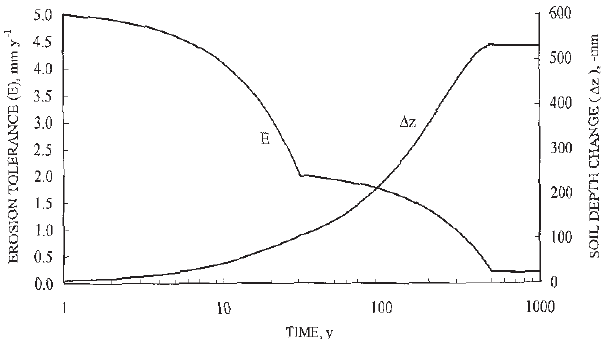
Figure 1. Shows an example of erosion tolerance determination considering the following values: E 0 = 5.0 mm y -1 , P = 0.2 mm y -1 , t 1 = 30 y, E 1 = 2.0 mm y -1 , t 2 = 500 y, E 2 = 0.2 mm y -1 and m 1 = m 2 = m 3 =